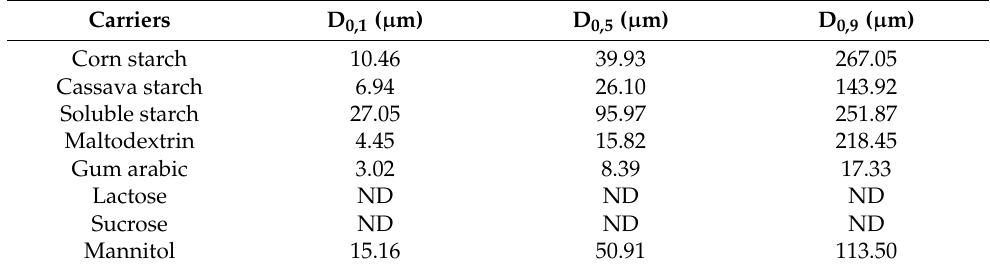
Table 2. Particle size distribution of the powders produced with each carrier by spray